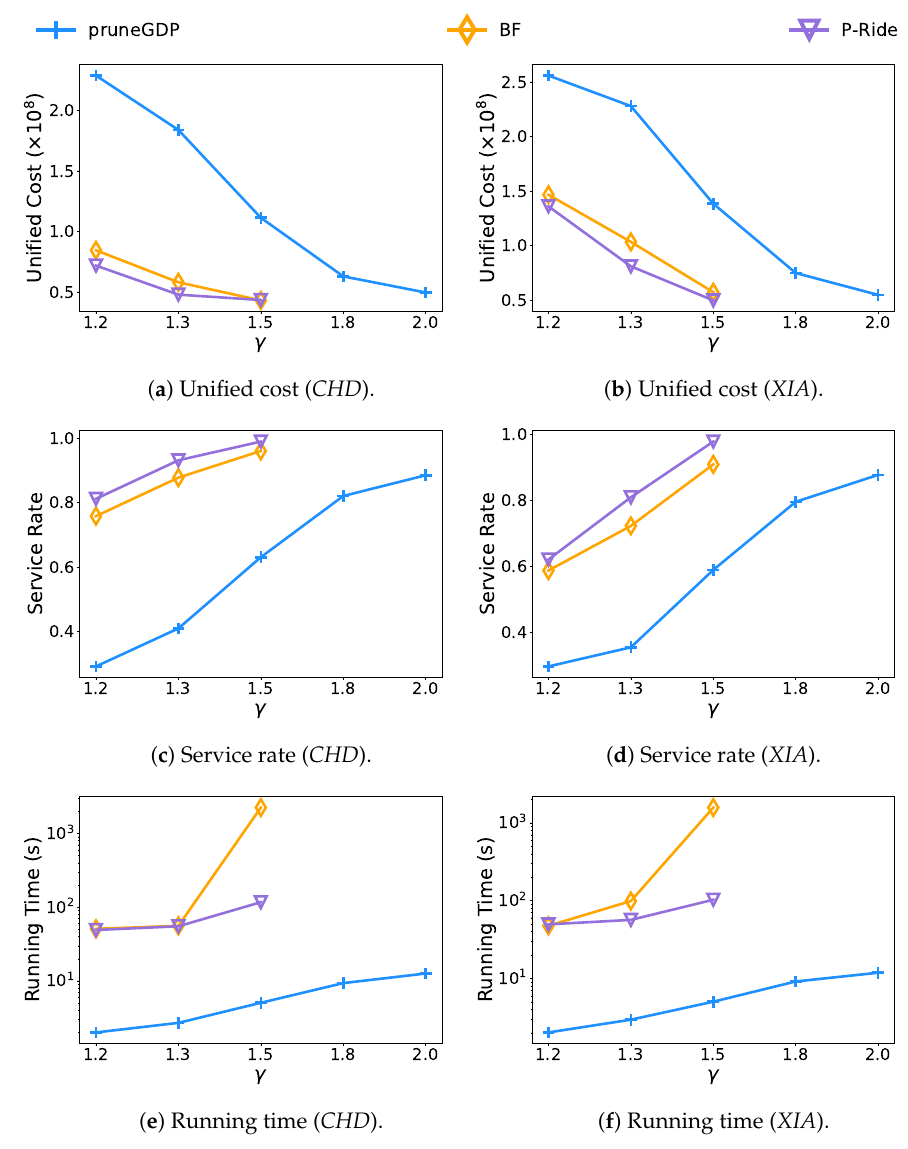
Figure 8. Performance of variance γ . Table 3. Details of road networks.